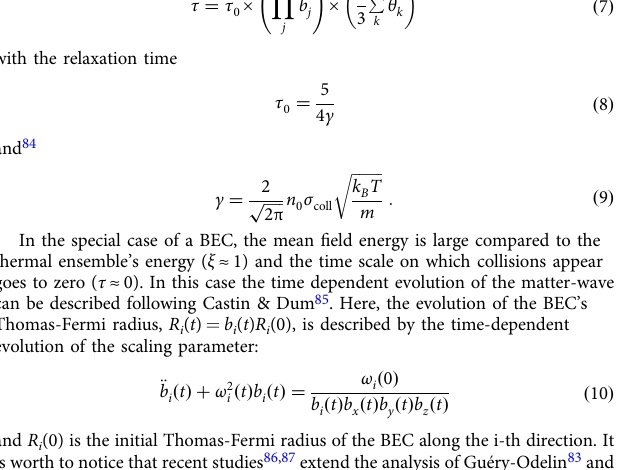
Fig. 5 Experimental setup. Optical setup of the dipole trap and alignment through the vacuum chamber. Vertical arrows point towards the 2D magneto-optical trap (2D-MOT) and the vacuum pumps. The acousto- optical modulator (AOM) is used for modulating the center-position of the laser beams and intensity control. A λ /2 wave plate rotates the polarization of the beam for best diffraction ef fi ciency of the AOM. Lenses L1 ( f 1 = 100 mm) and L2 ( f 2 = 300 mm) magnify the beam radius to about 3 mm, 4 mm (vertical, horizontal). Downstream lenses L3, L4, and L5 ( f 3,4,5 = 150 mm) focus, re-collimate and re-focus the beam into the center of the chamber. The λ /2 and the λ /4 wave plates set the polarization for maximum transmission at the orthogonal oriented polarization beam splitters (PBS). The mirrors (M) are used to guide the beam through the chamber. The purple arrow indicates the direction of absorption detection along the y-direction.